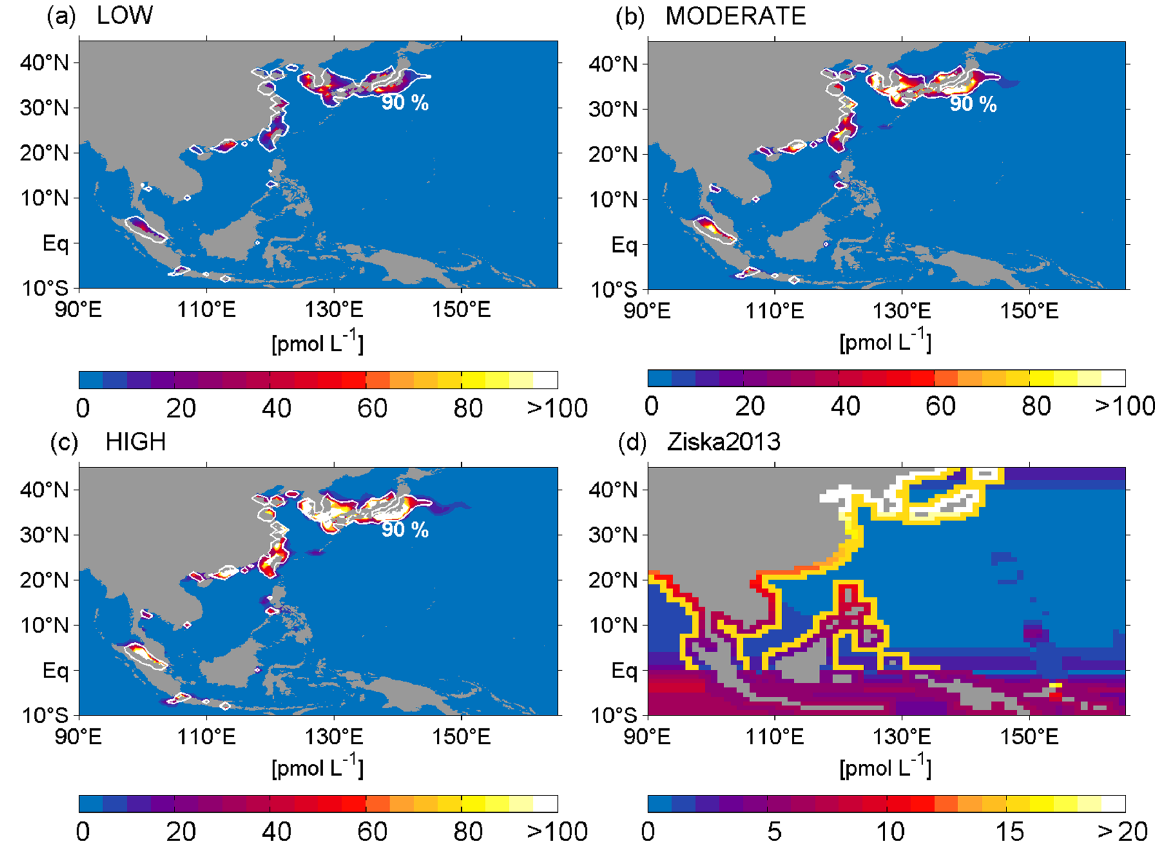
Figure 4. Annual mean surface bromoform concentration in pmolL − 1 for the three scenarios (a) LOW, (b) MODERATE and (c) HIGH as well as (d) the bromoform surface map updated from Ziska2013. Note that the colour bar limits for panel (d) vary from the limits in panels (a) – (c) . The white contour line in panels (a) – (c) shows the patches where 90% of the largest concentrations are